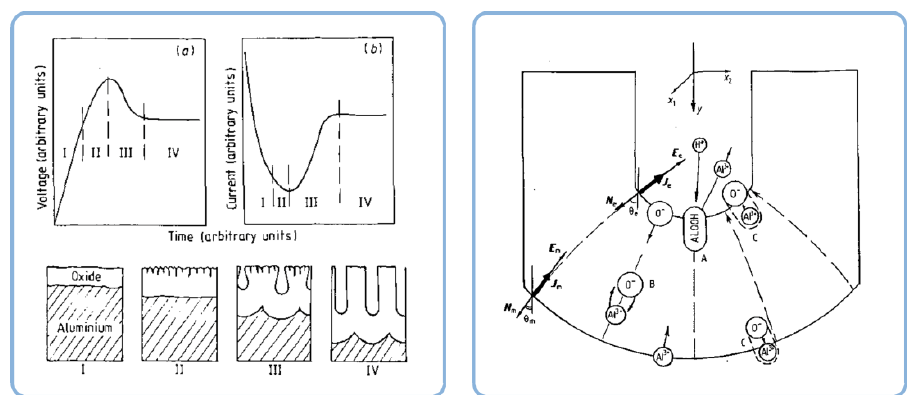
Figure 20. Left: a ∆ U – t ( a ) and an I – t ( b ) curve shape considered in Parkhutik–Shershulsky theory as typical for a galvanostatic and a potentiostatic anodizing process, respectively (above), and the corresponding stages of pore formation suggested in the model (below). Right: the elementary processes involved into the pore formation—namely, the field-assisted dissolution with the participation of positively charged H + ions ( A ), the movement of Al 3+ and O − through the “barrier layer” ( B ), and the oxide growth at both film interfaces ( C ). Reproduced with permission from [137]. Copyright 1992 IOP Publishing.